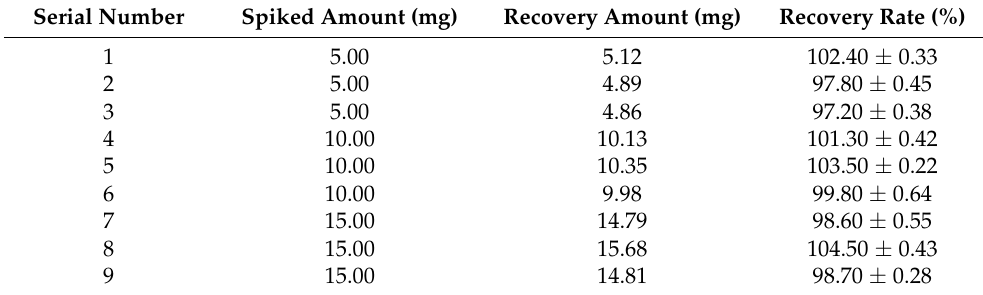
Table 4. Recovery rate of standard